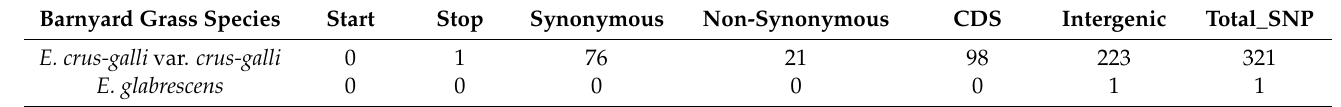
Table 6. Single-Nucleotide Polymorphism (SNP) in Echinochloa crus-galli var. crus-galli and E. glabrescens compared to E. crus-galli var. crus-galli . Barnyard Grass